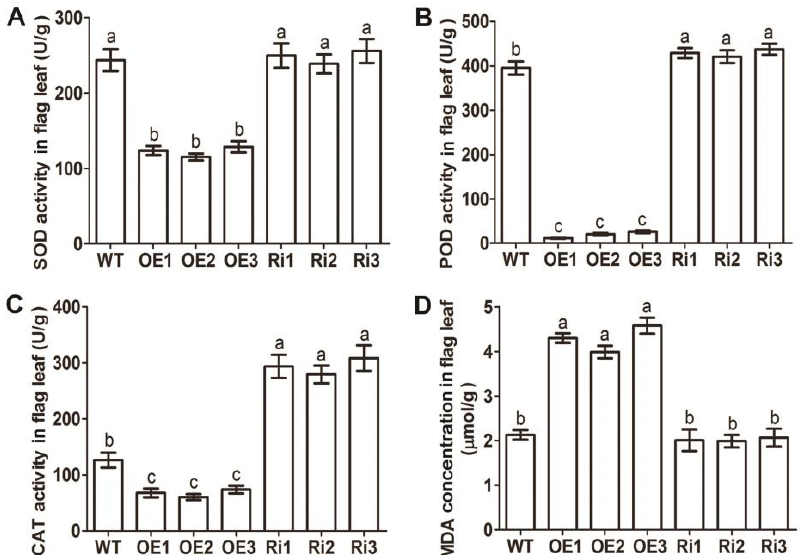
Figure 2. Superoxide dismutase (SOD) activity ( A ), peroxidase (POD) activity ( B ), catalase (CAT) activity ( C ), and malondialdehyde (MDA) concentration ( D ) of the OsAAP3 OE lines, Ri lines, and wild-type (WT) at the heading stage. The flag leaves was taken at 110 days after sowing. The letters above the error bars are ranked by the Duncan test at p < 0.05. Values are means ± standard deviation ( n = 5).